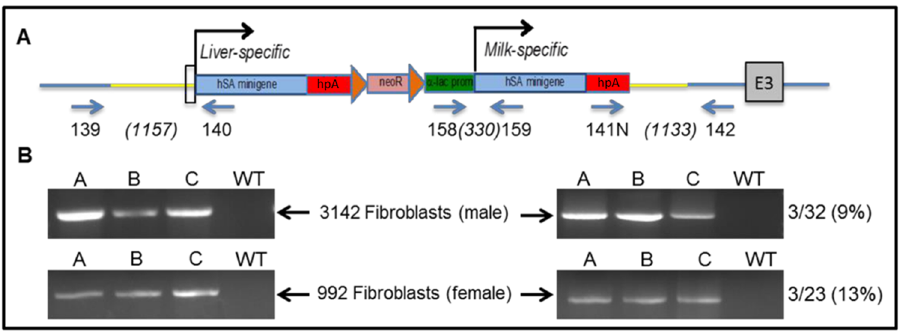
Figure 2. Targeted integration of pHSA-neo at the bA locus. (A) Schematic representation of HDR at the bA gene. Primer 139 is located upstream of the 5 9 homologous arm and primer 140 is located at the 5 9 end of HSA1. Primer 141N is located within the human growth hormone polyadenylation (hpA) sequence of HSA2 and primer 142 is located downstream of the 3 9 homologous arm. Yellow lines represent the homologous arms of the construct. Figures in brackets indicate the expected product sizes. (B) PCR analysis of HDR at the bA locus for the 5 9 (left) and 3 9 (right) regions of pHSA-neo. Positive clones derived from the 3142 and 992 cell lines are indicated by A, B, C. Non-transfected (wild-type; WT) DNA from both cell lines was used as a negative control. Targeting efficiency for each cell line is shown at the right. monoallelic recombination efficiencies of 9.4% (3/32 clones) and 13% (3/23 clones) for the male 3142 and female 992 lines, respectively. Biallelic modifications were not identified in any of